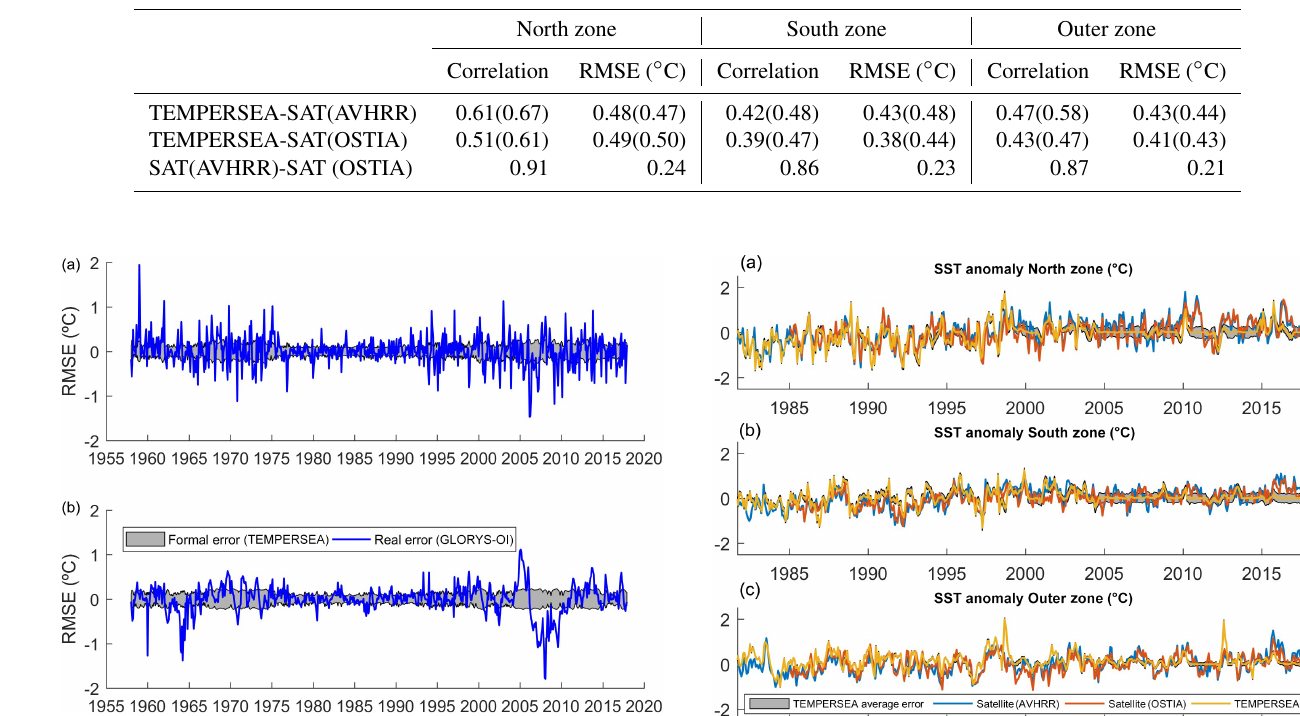
Table 1. Statistics of the comparison of regionally averaged SST monthly anomalies between TEMPERSEA, AVHRR and OSTIA. In brackets are the values when only periods with enough in situ observations (i.e. formal error <0.15 ◦ C) are considered.